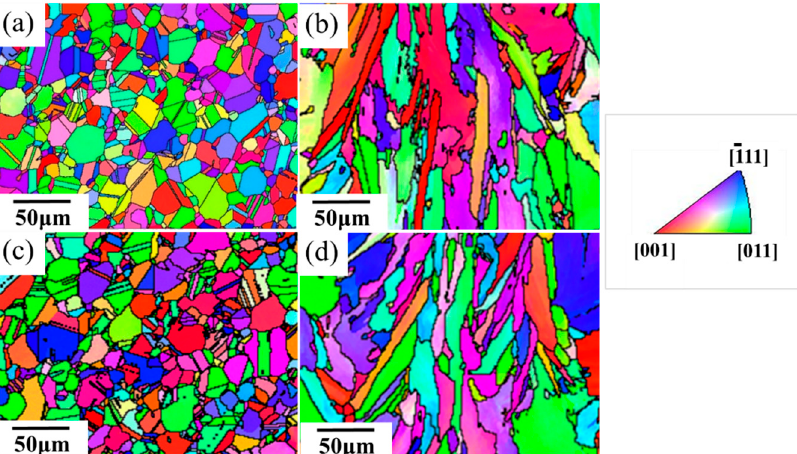
Figure 6. Inverse pole figures (IPFs) of ( a ) as-HIPed; ( b ) as-built SLM; ( c ) HIP + solution treatment and aging (HIP + STA) and ( d ) SLM + STA specimens were analyzed using the orientation measurements by electron backscatter diffraction (EBSD).